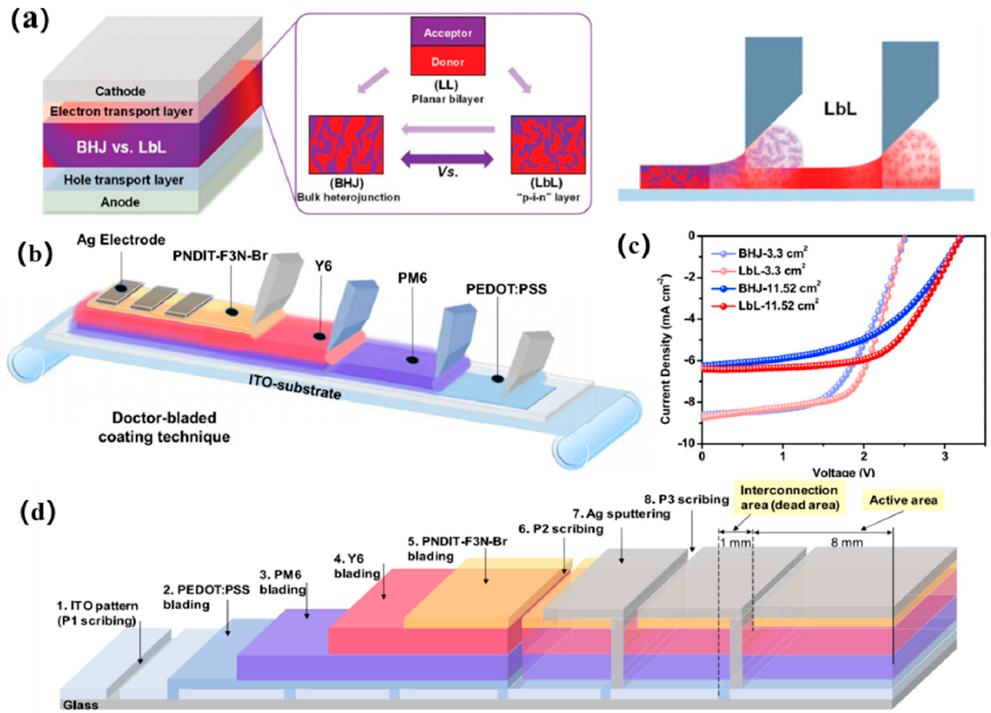
Figure 7. ( a ) Schematic of device architecture with different active layers and sequential blade coating method. Adapted with permission from Ref. [50]. Copyright 2019 the Royal Society of Chemistry. ( b ) Schematic illustration of the LBL blade coating and device architecture of OSCs [87], ( c ) J – V curves of BHJ and LBL devices using blade coating method. ( d ) Large-area solar modules for blade coating process. Adapted with permission from Ref. [51]. Copyright 2019 Elsevier Inc.